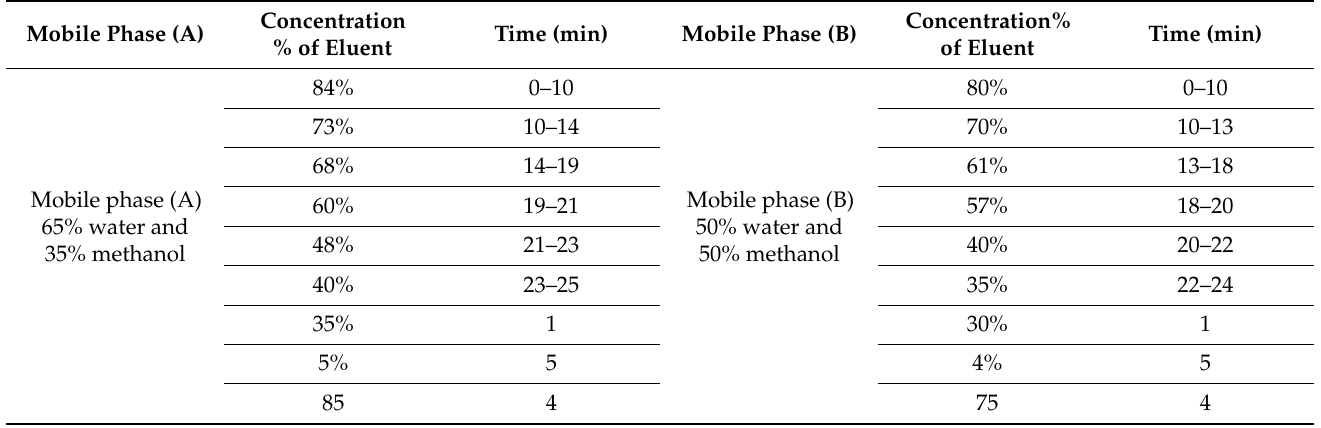
Table 1. Timetable of HPLC conditions and